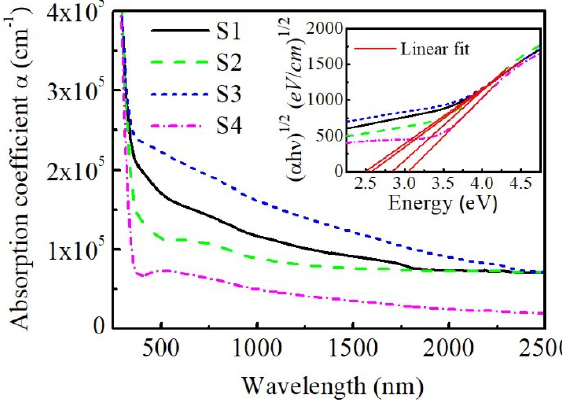
Fig. 4. Absorption coefficient in the visible to NIR range, with the Tauc plot analysis in the